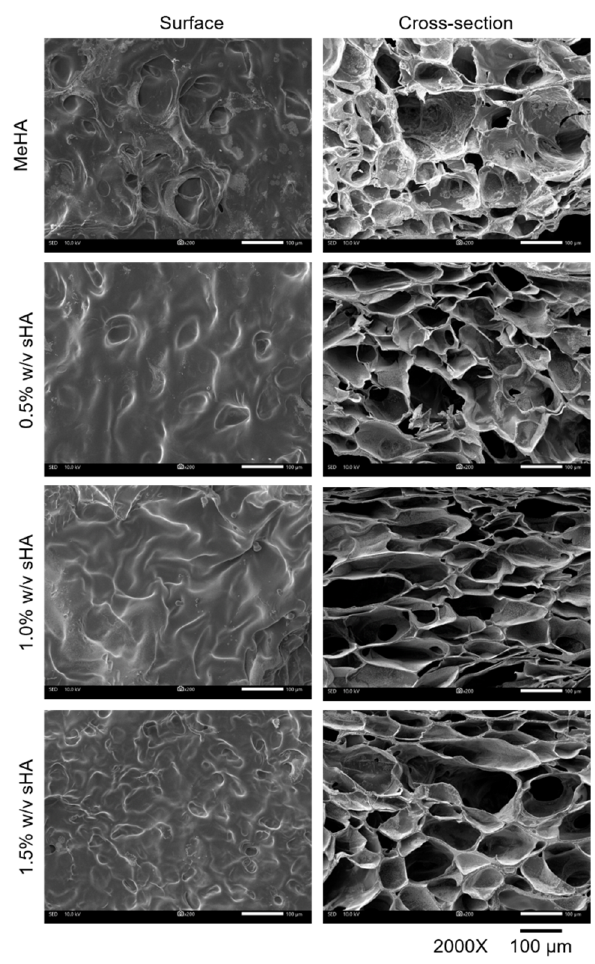
Figure 4. Microstructure images of freeze-dried hydrogels captured by using SEM technique. The scale bars of 2000× magnification are 100 µm.